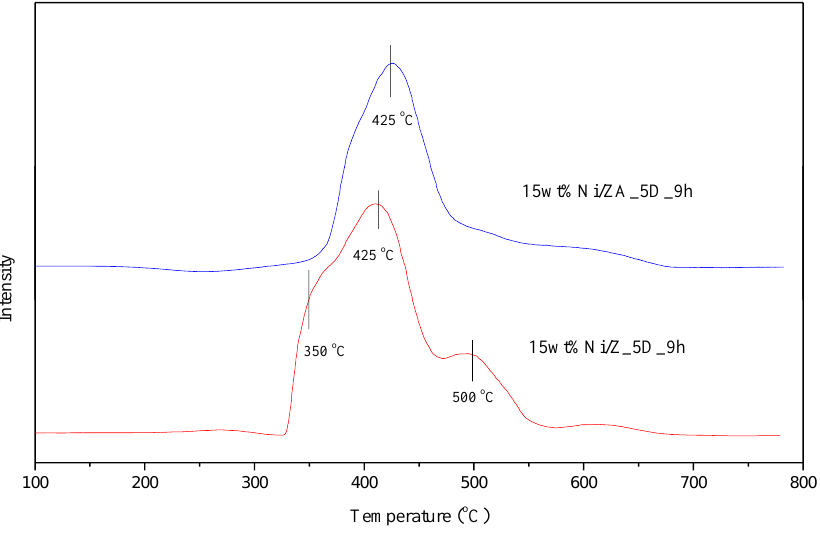
Figure 6. H 2 -TPR of 15wt%Ni/Z_5D_9h and 15wt%Ni/ZA_5D_9h. In order to accerelate the CO 2 methanation reaction, increasing the reactants’ (H 2 and CO 2 ) adsorption ability is crucial. H 2 favors dissociative adsorption on metal site; thus, CO 2 adsorption also would favor being adsorbed on zeolite support for this case. In order to show that zeolite was a CO 2 adsorption site, a CO 2 uptake experiment by TG/DTA was employed. Figure 7a illustrates CO 2 uptake of 15wt%Ni impregnated on those two kinds of zeolite supports compared with NiO. It shows that 15wt%Ni/ZA_5D_9h exhibited higher CO 2 uptake than 15wt%Ni/Z_5D_9h, even though the former sample had a lower surface area (14.11 m 2 /g for 15wt%Ni/ZA_5D_9h and 25.66 m 2 /g for 15wt%Ni/Z_5D_9h). This indicated that added NiO on Z_5D_9h covered zeolite surface and blocked the CO 2 adsorption site, which led to a lowering of CO 2 uptake. Moreover, CO 2 uptake of bare zeolite and NiO were also reported to evidence that CO 2 was favor to adsorb on zeolite support. It shows that ZA_5D_9h had the highest CO 2 uptake while NiO was not adsorbing CO 2 . To further investigate the binding strength of CO 2 and the catalyst surface, CO 2 -TPD was employed. Figure 7b illustrates the CO 2 -TPD profiles of 15wt%Ni/ZA_5D_9h and 15wt%Ni/Z_5D_9h. Normally, the CO 2 -TPD profile can be divided into three regions (weak, medium, and strong), which were categorized by the binding strength between CO 2 and the catalyst surface. Only weak (<300 ◦ C) and medium (300 − 500 ◦ C) peaks, which attributed to weak and medium interaction between CO 2 and the catalyst surface, were con- sidered. However, the strong peak (>500 ◦ C), which was assigned to strong interaction be- tween them, was negligible [43]. Figure 7b shows that 15wt%Ni/ZA_5D_9h catalyst exhib- ited three peaks while only weak and strong peaks were observed for 15wt%Ni/Z_5D_9h. Since the peak area of the desorbed amount of CO 2 is directly related to the adsorption amount, the areas of weak and medium peaks were compared. The peak areas of those two peaks of the two catalysts were 0.547 and 1.331 mmol/g for 15wt%Ni/Z_5D_9h and 15wt%Ni/ZA_5D_9h, respectively. It clearly shows that the latter catalyst exhibited much higher CO 2 adsorption amount than the former, which is in agreement with the CO 2 uptake results shown in Figure